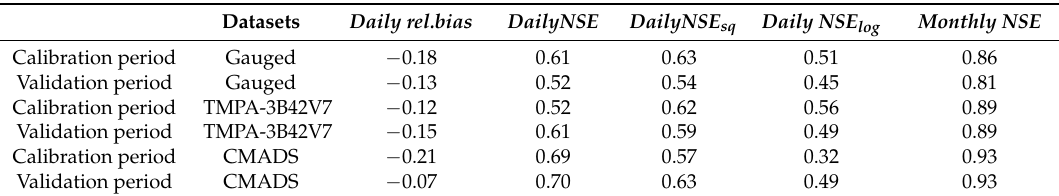
Table 7. Model performance of the IHACRES model (calibrated using NSE ) for the calibration period and validation